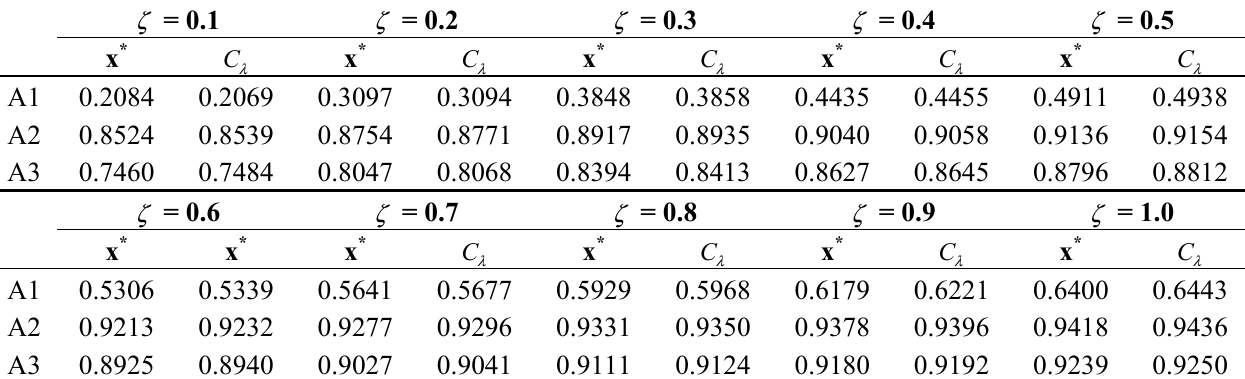
based on each grey relational coefficient ( ζ λ